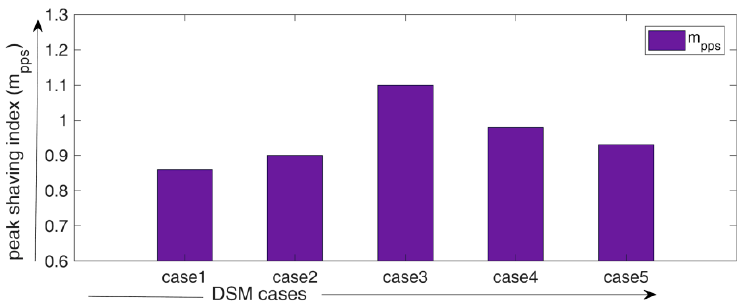
Figure 8. Illustrative graph for peak power shaving index.